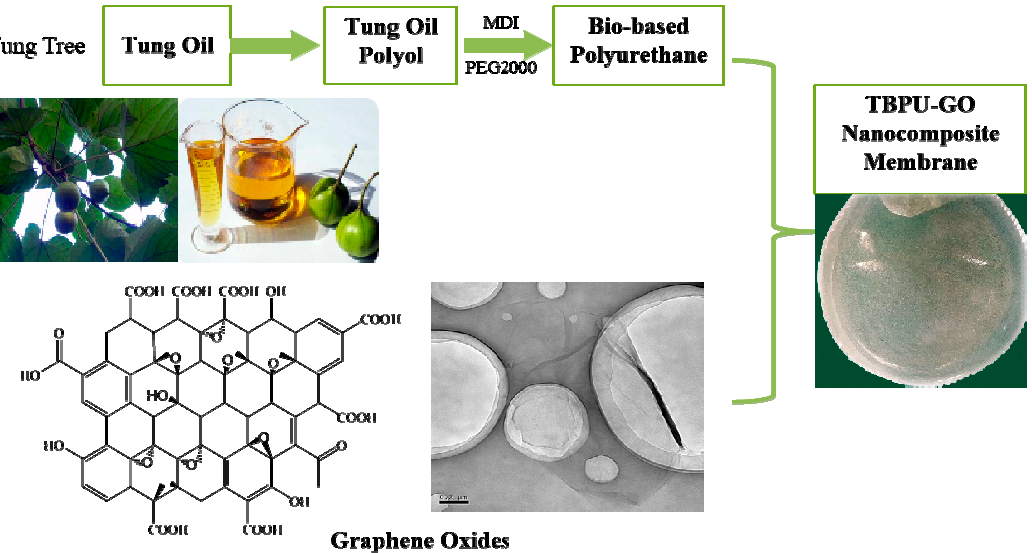
Figure 1. The schematic representation of the GO/TBPU nanocomposite membrane.